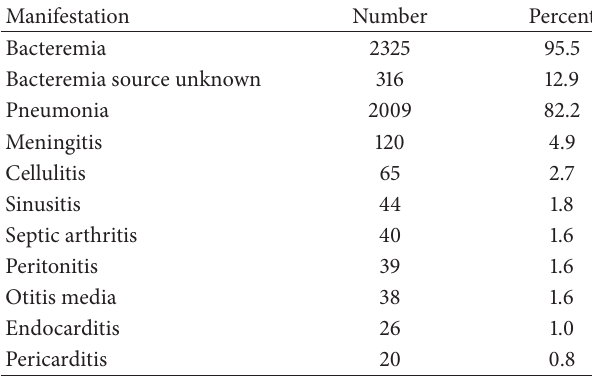
Table 4: Manifestations of invasive pneumococcal disease among 2435